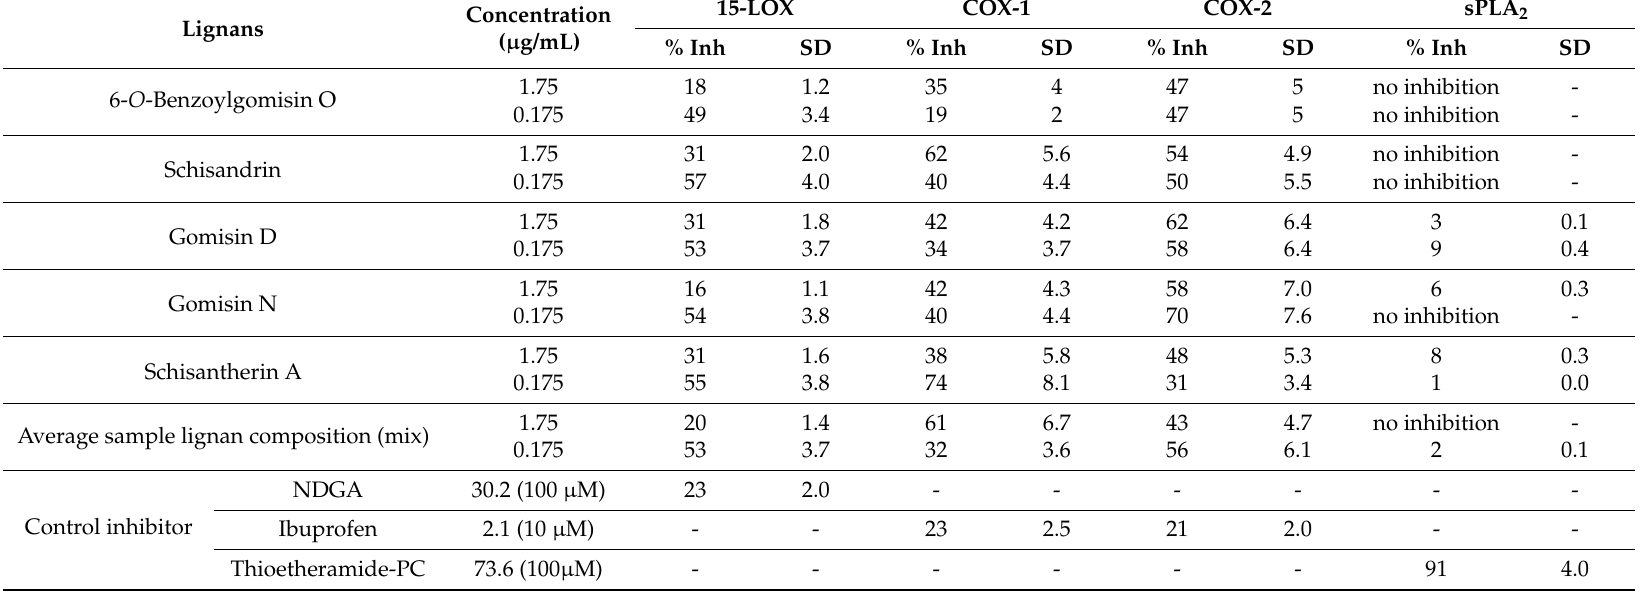
Table 4. In vitro inhibition activity of selected pure lignan solutions against 15-LOX, COX-1, COX-2, and sPLA 2